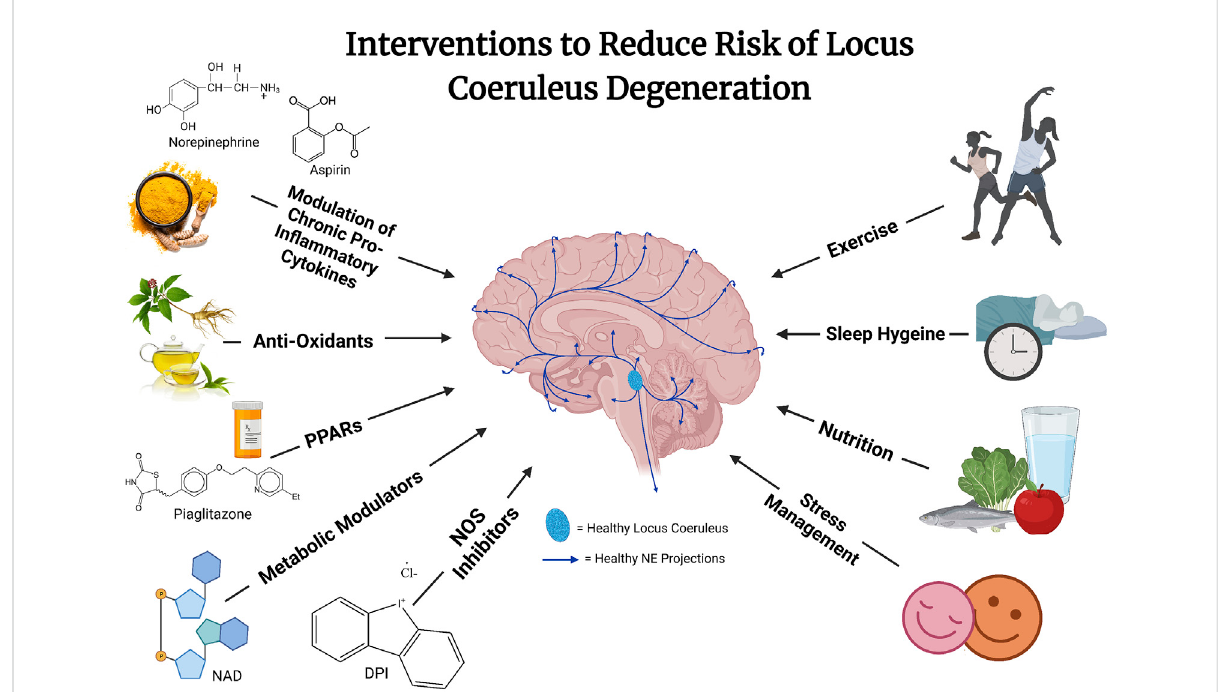
FIGURE 2 The risk of locus coeruleus degeneration may be reduced through a combination of different interventions. These interventions remain hypothetical and likely will work in concert to reduce vulnerability to what is likely a multi-dimensional disease etiology. Future well designed and controlled studies are needed to explore the ef fi cacy of these